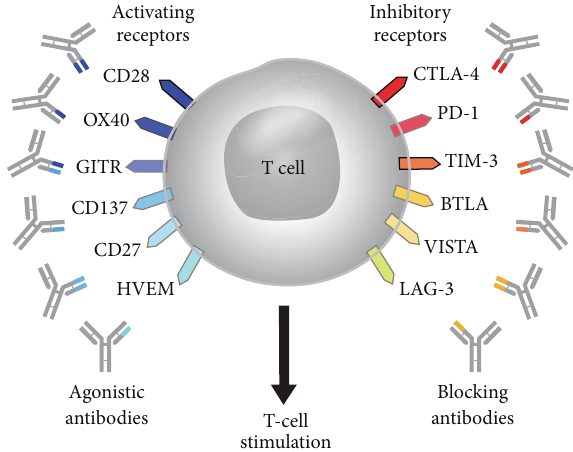
Figure1:T-celltargetsforimmunoregulatoryantibodytherapy[10]; reproduced with permission from Mellman et al. 2011